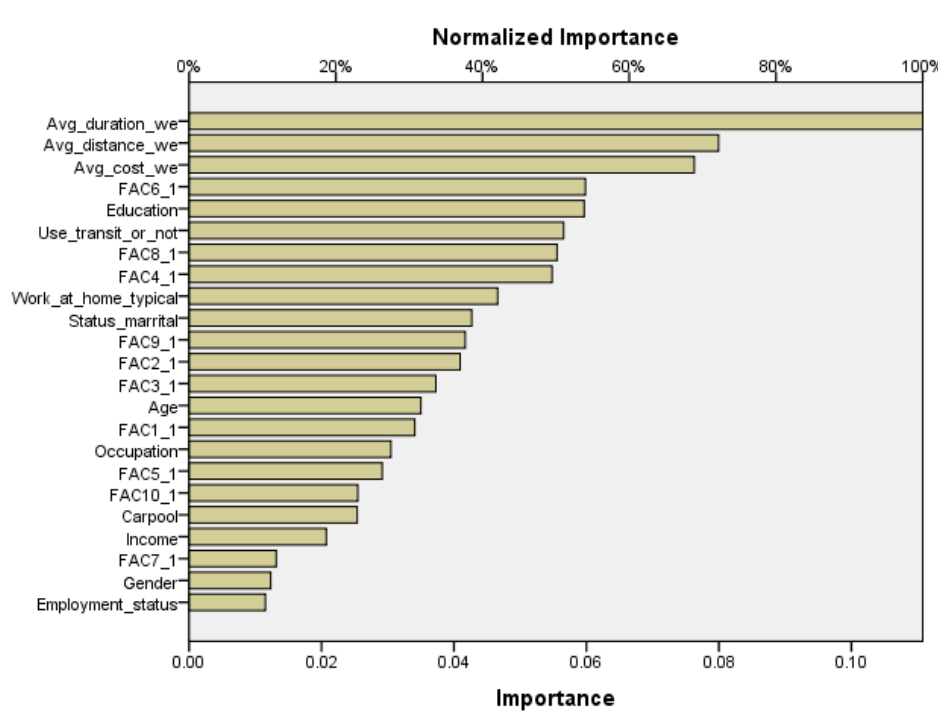
Figure 12. Normalized importance.